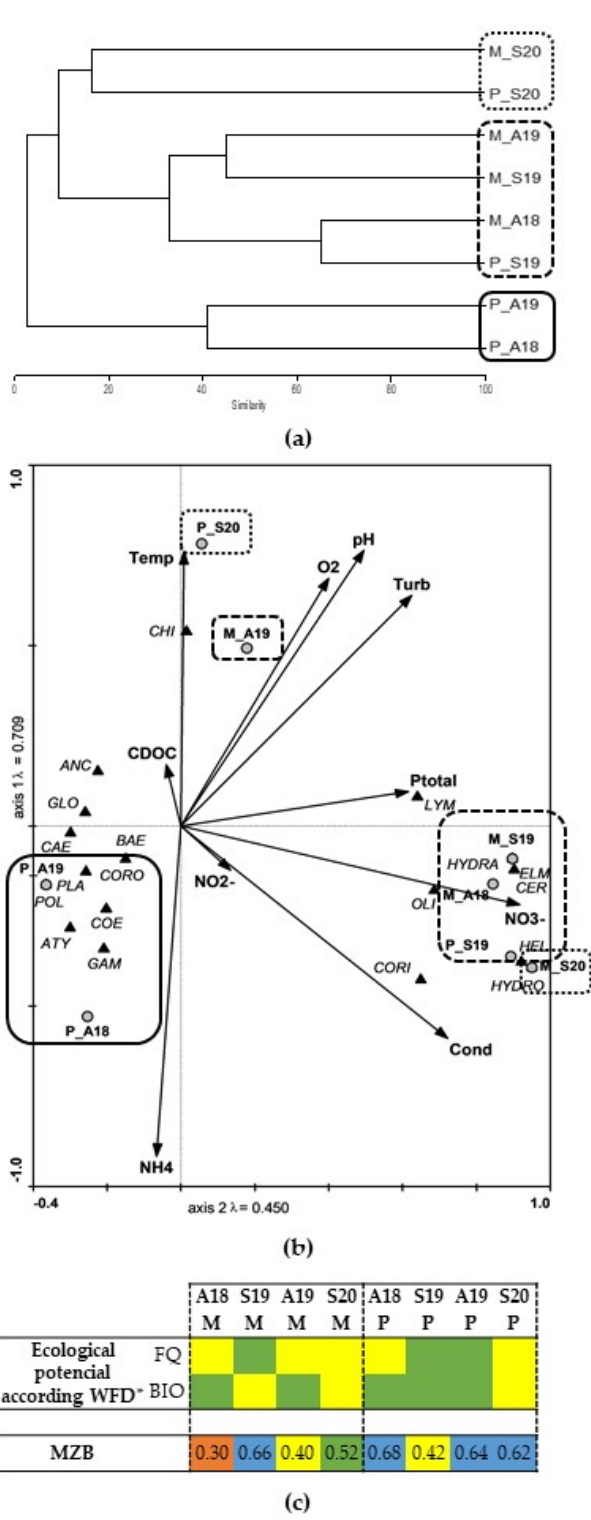
Figure 2. ( a ) Miranda and Pocinho complete linkage dendrogram of benthic macroinvertebrates similarity; ( b ) Canonical Correspondence Analysis (CCA) of the distribution of aquatic invertebrates (see taxa abbreviation in Table 2); ( c ) ecological potential according to WFD parameters (* see Table 1 for more information) and macrozoobenthos index for dam reservoirs (MZB) through the sampling sites, periods, and environmental variables.